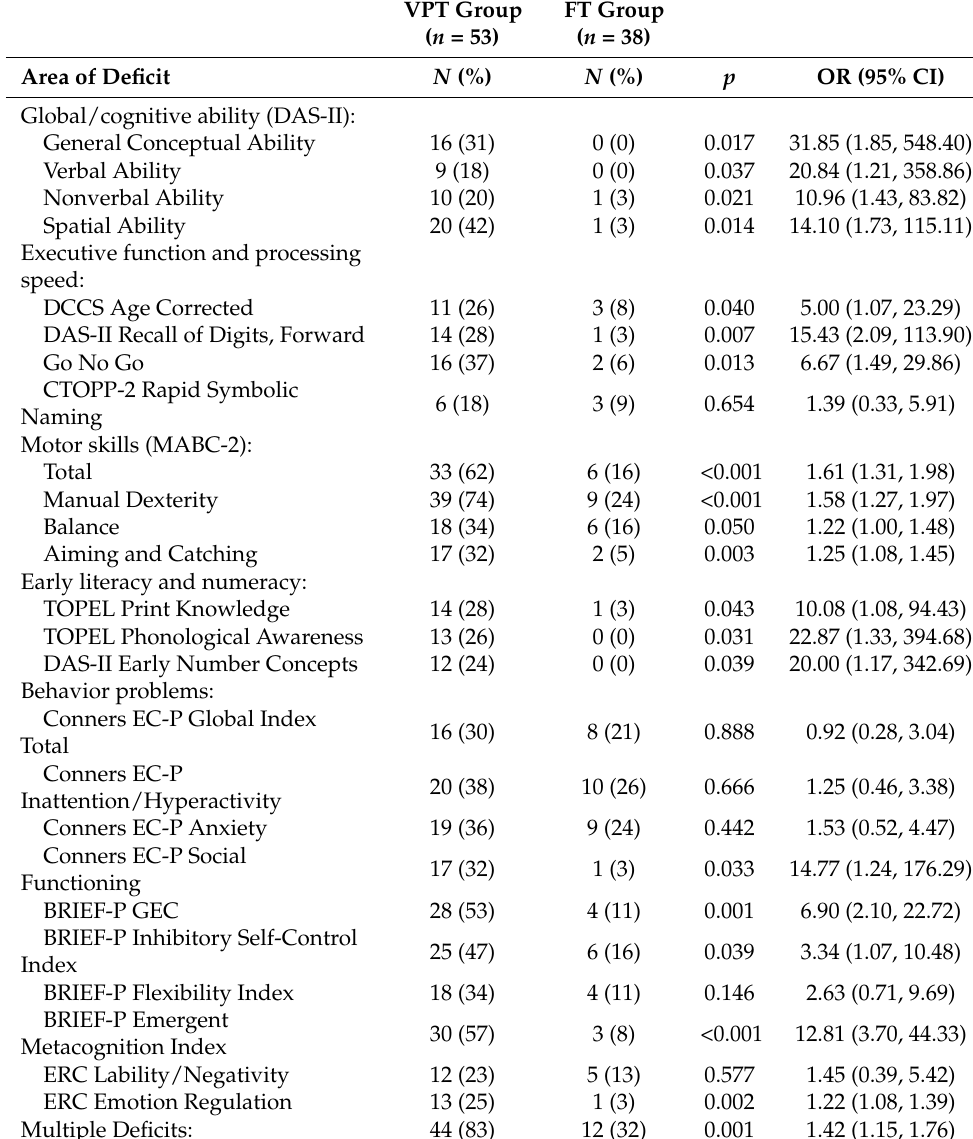
Table 4. Group differences in rates of deficits in school